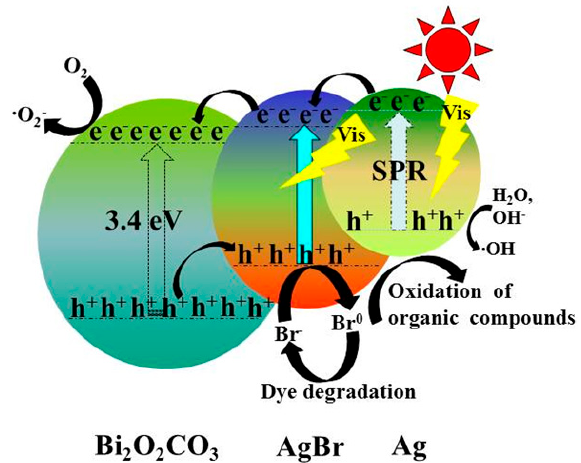
Figure 14. Schematic diagram of the separation of electron–hole pairs over Ag@AgBr/Bi 2 O 2 CO 3 under visible light irradiation.